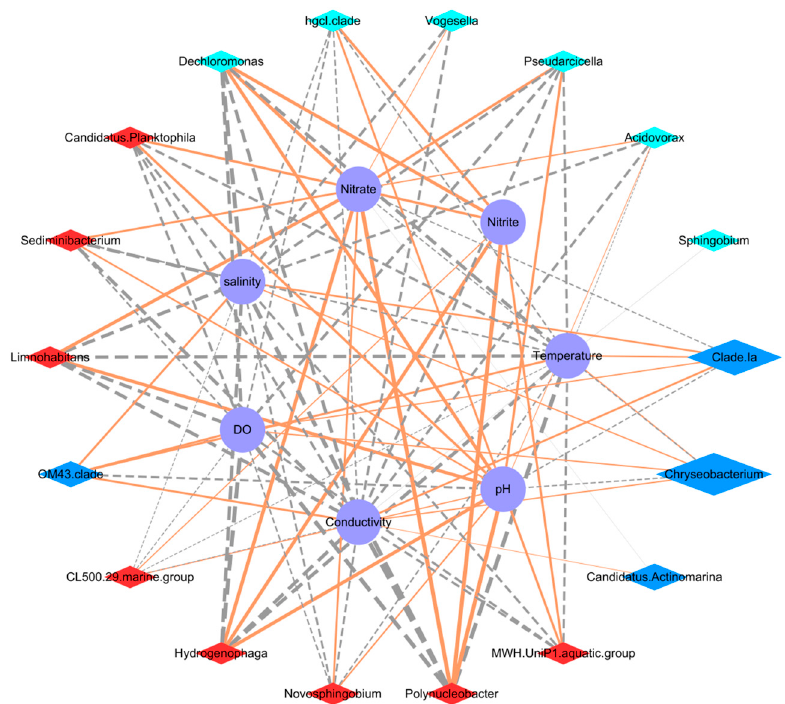
Figure 4. Network analysis of relationship between taxon abundance (at genus level) and environmental variables. Note: The circle represents the environmental factor, and the diamond represents the genus. The size of the diamond was proportional to the relative abundance of the given genus. The different colors of the diamond indicate the difference of the genus between coastal area D and S: blue indicates coastal area S was significantly lower than D, red indicates coastal area S was significantly higher than D, and sky blue indicates no significant difference. Lines represent the correlations between environmental factors and genera: the orange solid line represents a significant positive correlation, and the gray dashed line represents a significant negative correlation. The width of the line represents the strength of the relationship (the maximal information coefficient (MIC) value). Table 4. Maximal Information-based Nonparametric Exploration (MINE) network of environmental Table 3. Mantel test of the effects of environmental factors on the bacterial community composi- tions.